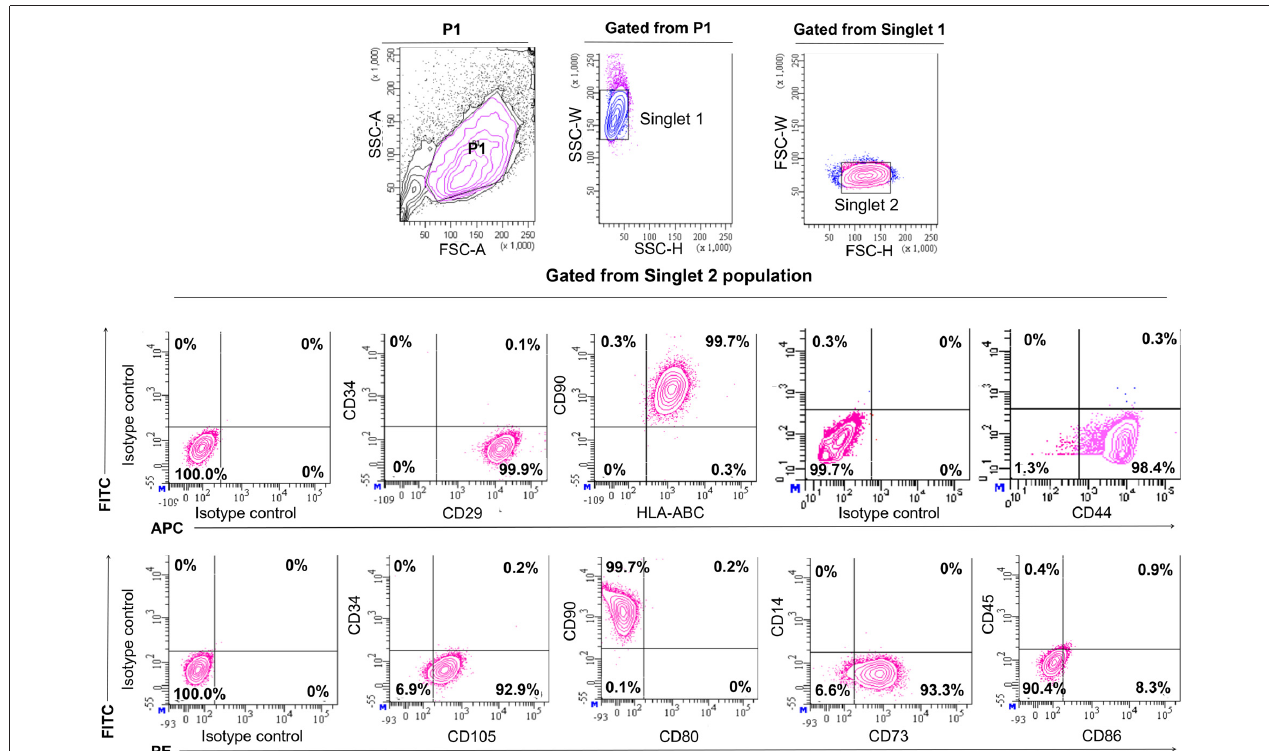
FIGURE 1 | Immunophenotyping of human mesenchymal stem cells from Wharton’s jelly. Characterization of Mesenchymal Stem Cells (MSCs) for the expression of surface markers by flow cytometric analysis on the third passage. Cell population was gated as P1. Identification of singlet cells (singlet 1 and singlet 2) were used to remove cell clumps remaining after disaggregation and to eliminate autofluorescence events. The remaining events were considered to be singlet cells. Flow cytometry showed that gated cell populations from singlet 2 were positive for CD90, CD73, CD105, CD29, CD44 and HLA-ABC but did not express CD34, CD14, CD45, CD80 and CD86. For each antibody, isotype-matched mouse immunoglobulin γ antibody was used in unstained